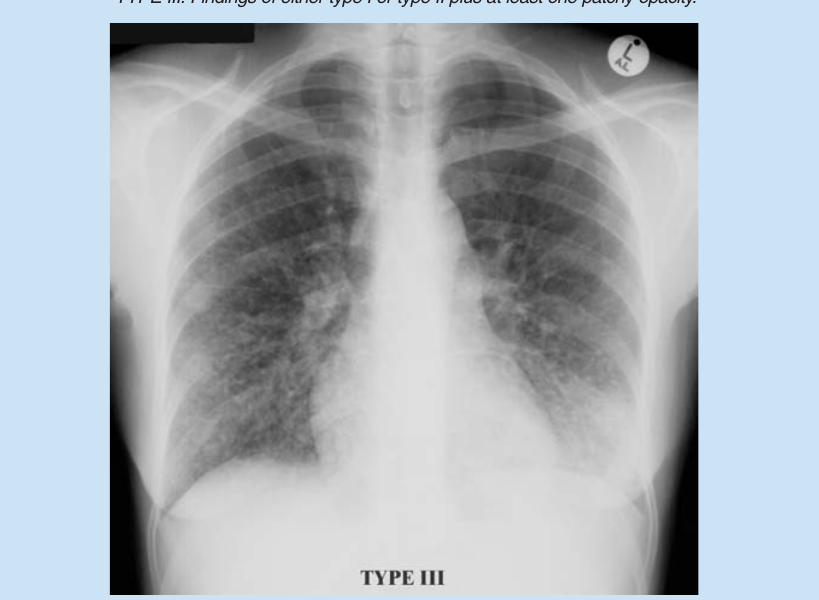
Fig. 4. Forty-year-old female patient. No history available.